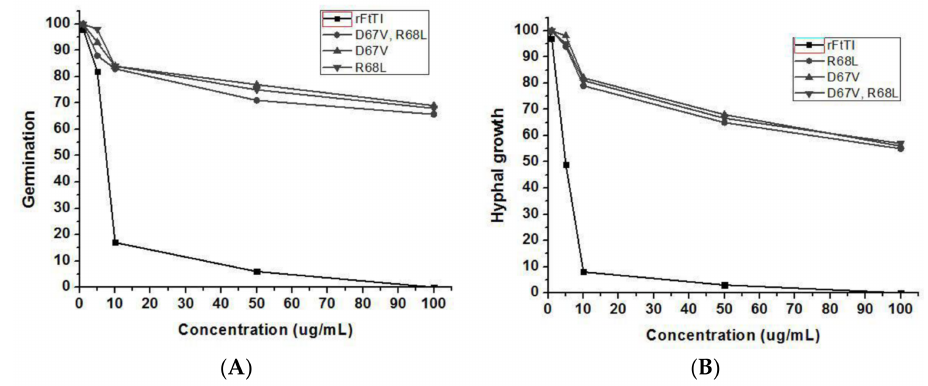
Figure 4. Inhibitory effects of the recombinant FtTI protein at various concentrations on the hyphal growth ( A ) and conidial germination ( B ) of A. solani . The results are expressed as relative values compared to those of untreated controls (set to 100%).